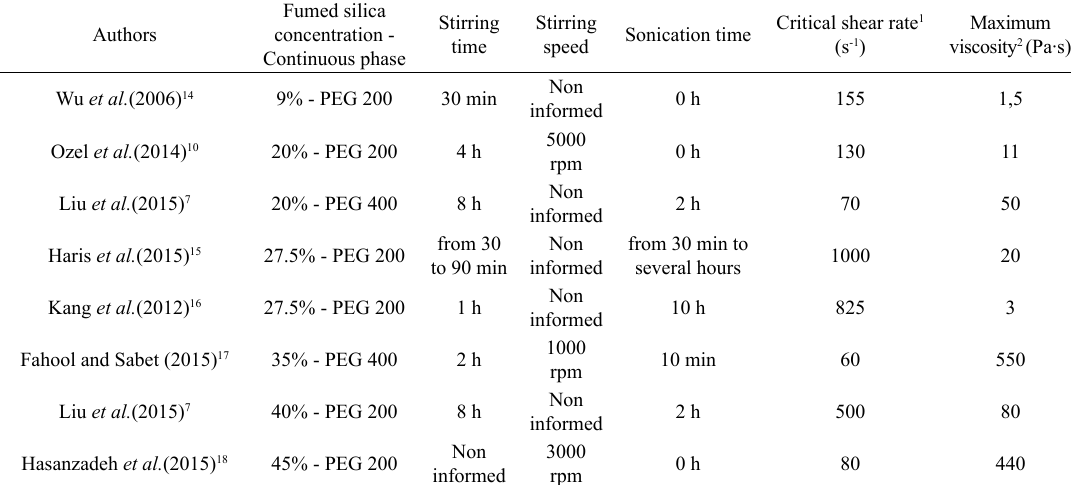
Table 1. Rheological studies of silica-poly(ethylene glycol) suspensions. Authors